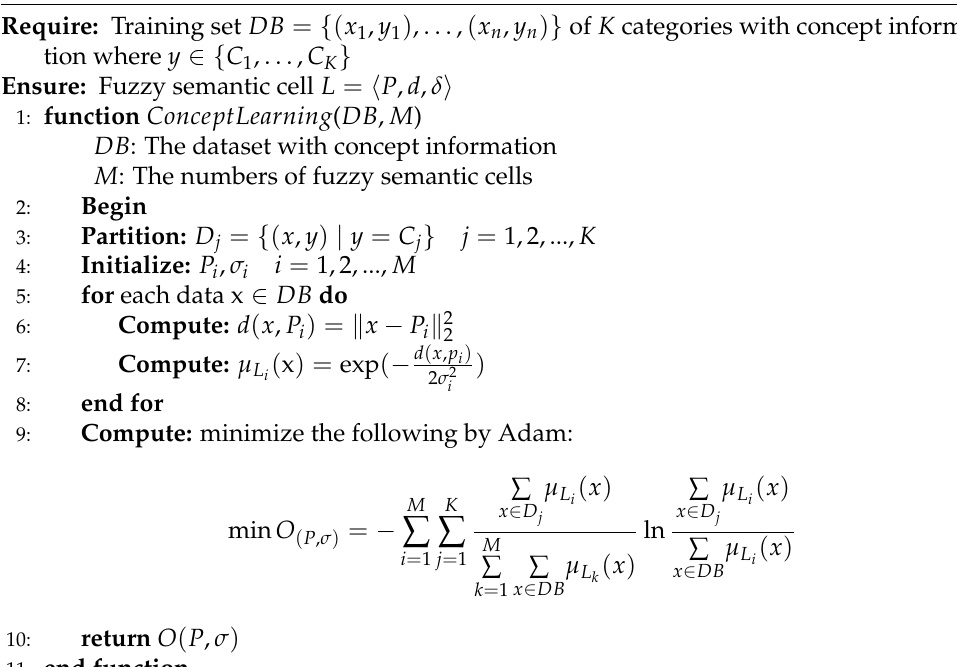
Algorithm 1 Hierarchical Concept Learning by Fuzzy Semantic